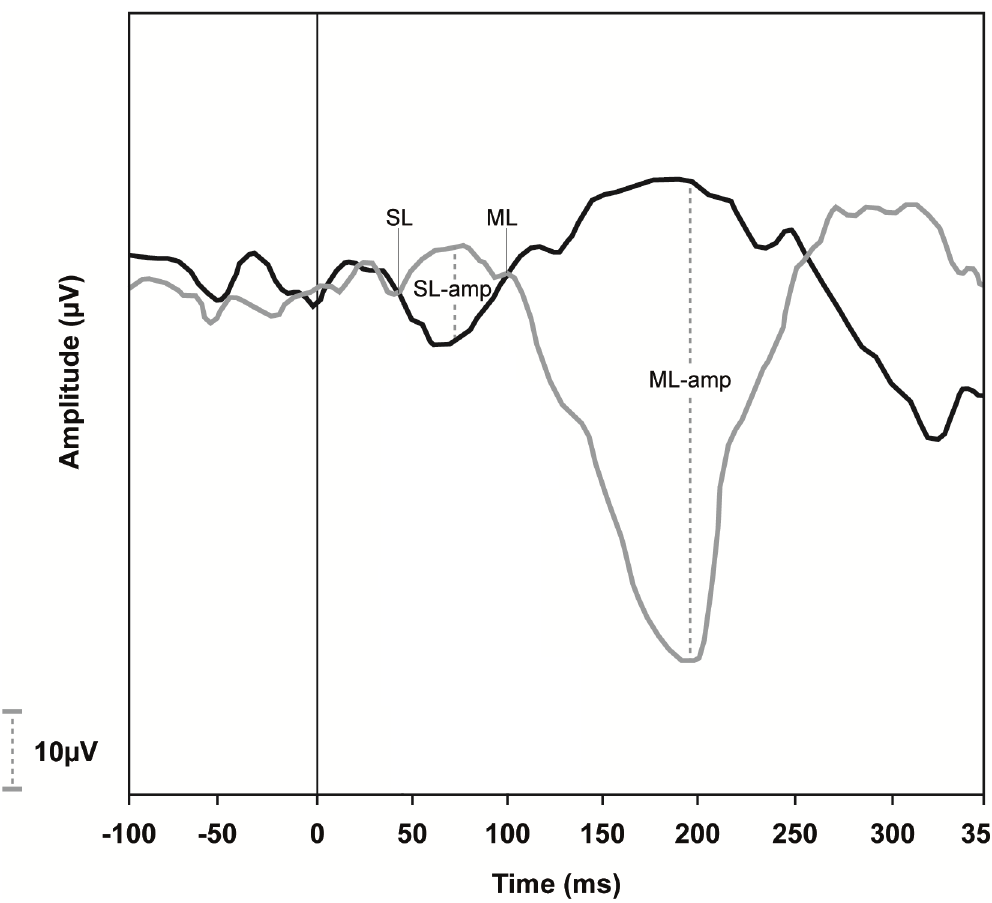
Fig 2. A normal vestibular-evoked myogenic potential triggered by galvanic vestibular stimulation (galvanic-VEMP) tracing. These recordings were obtained from an uninfected individual with his head rotated to the left and electromyographic (EMG) response recorded from the right gastrocnemius muscle. The black line indicates the trace recorded with the cathode and anode on the right and left side (CRAL), respectively, whereas the gray line indicates the opposite stimulation polarity (CLAR). SL, short-latency response (47 ms); ML, medium-latency response (100 ms); SL-amp, SL amplitude (12.5 μV); ML- amp, ML amplitude (62.5